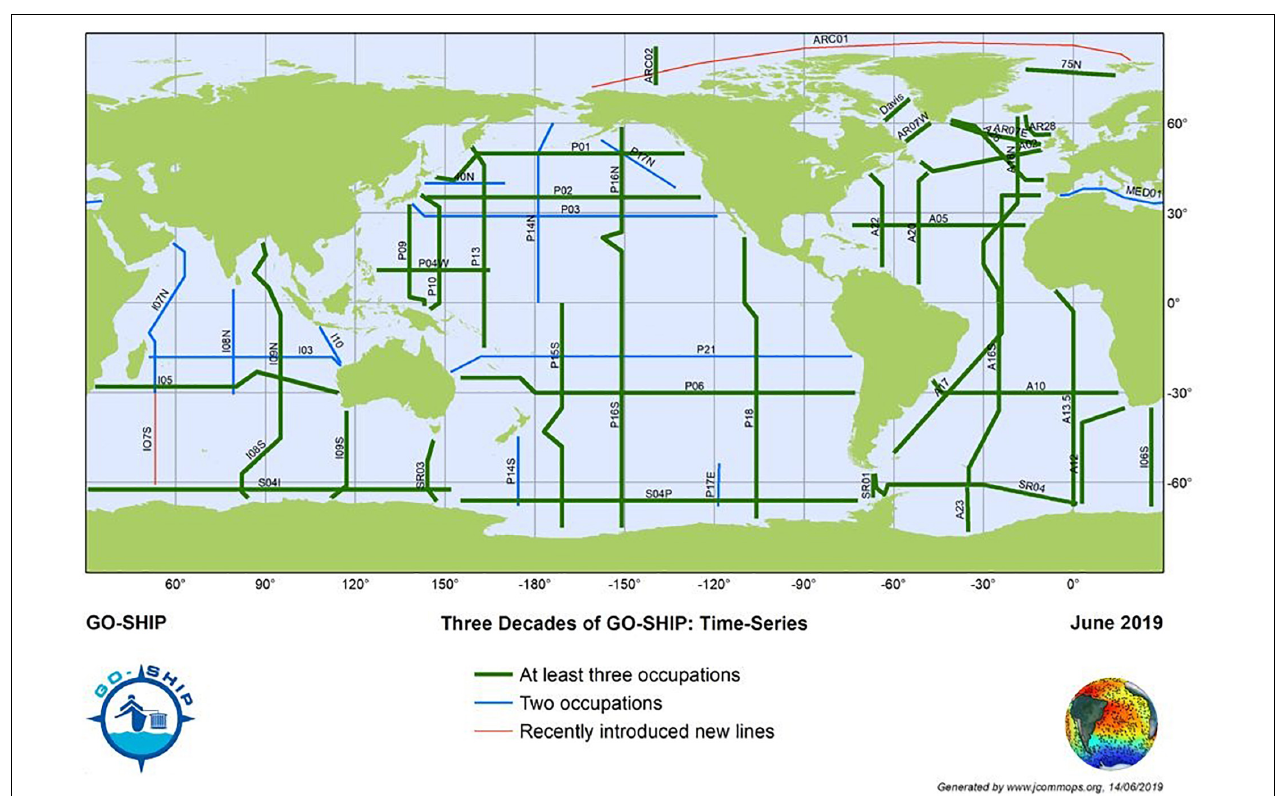
FIGURE 5 | Time-series of GO-SHIP sections, taking into account cruises which have already been confirmed for occupation in the future. Many of the decadal full GO-SHIP sections have now been occupied three or more times. Individual occupations of the sections can be accessed from CCHDO, however, as the number of section repeats increases improved data accessibility of the section time-series should be